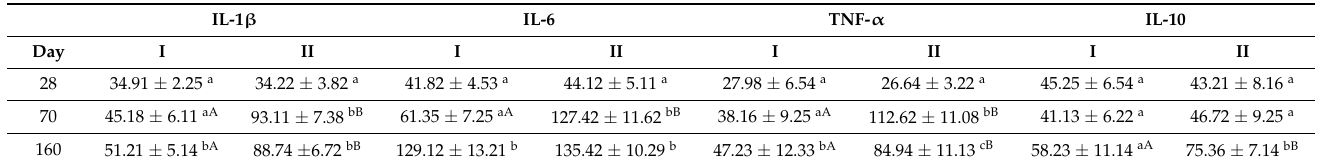
Table 5. Serum concentrations of IL-1 β , IL-6, TNF- α and IL-10 in pigs from groups I and II. Values are expressed as the mean and standard deviation ( α +/ −